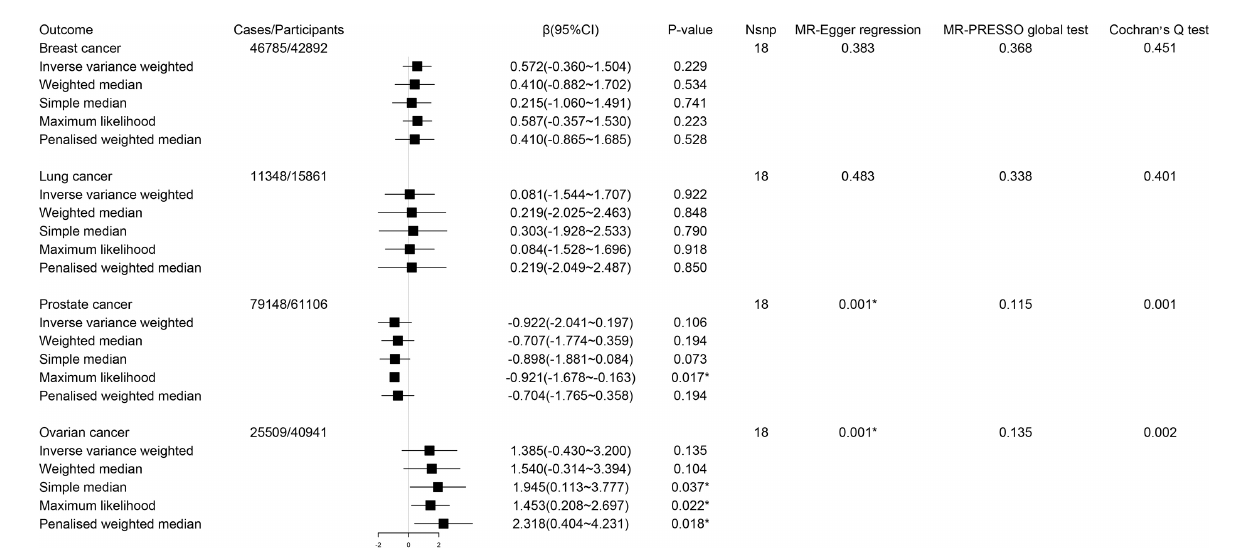
FIGURE 2 | Forest plot for associations between circulating tryptophan levels and the risk of site-speci fi c cancers. b , beta value; CI, con fi dence interval; Nsnp, number of the SNPs; *P <